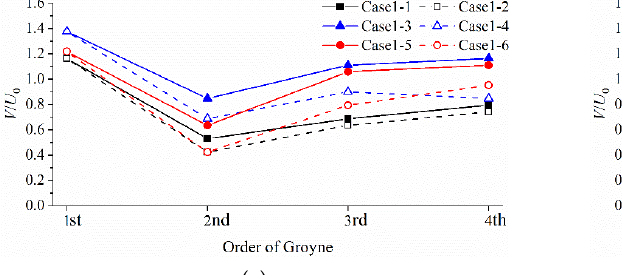
Figure 3. Velocity distribution in typical cross section: ( a ) Section CS06 (fixed bed), ( b ) Section CS06 (mobile bed), ( c ) Section CS10 (fixed bed), ( d ) Section CS10 (mobile bed), ( e ) Section CS14 (fixed bed) and ( f ) Section CS14 (mobile bed).